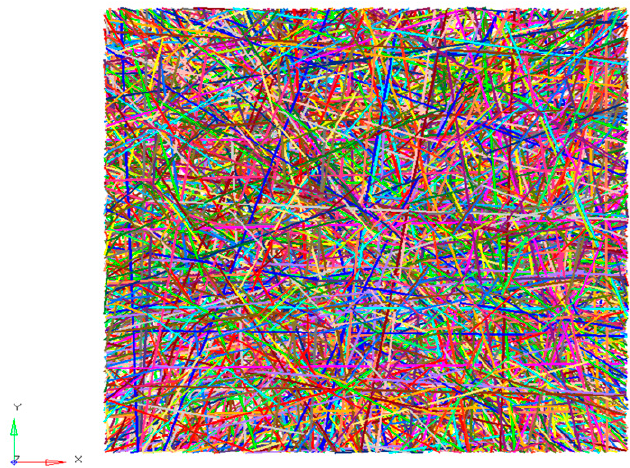
Figure 12. Finite element model of bend fibers.